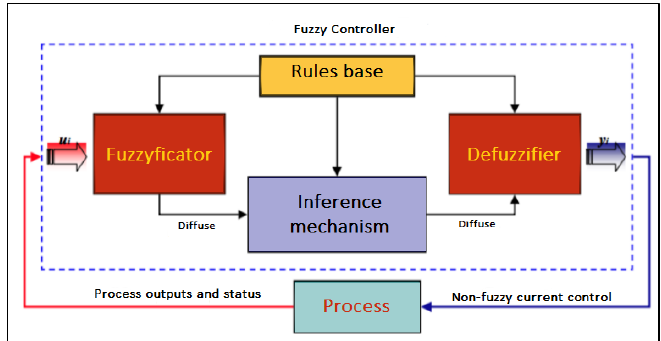
Figure 1: General scheme of fuzzy control.